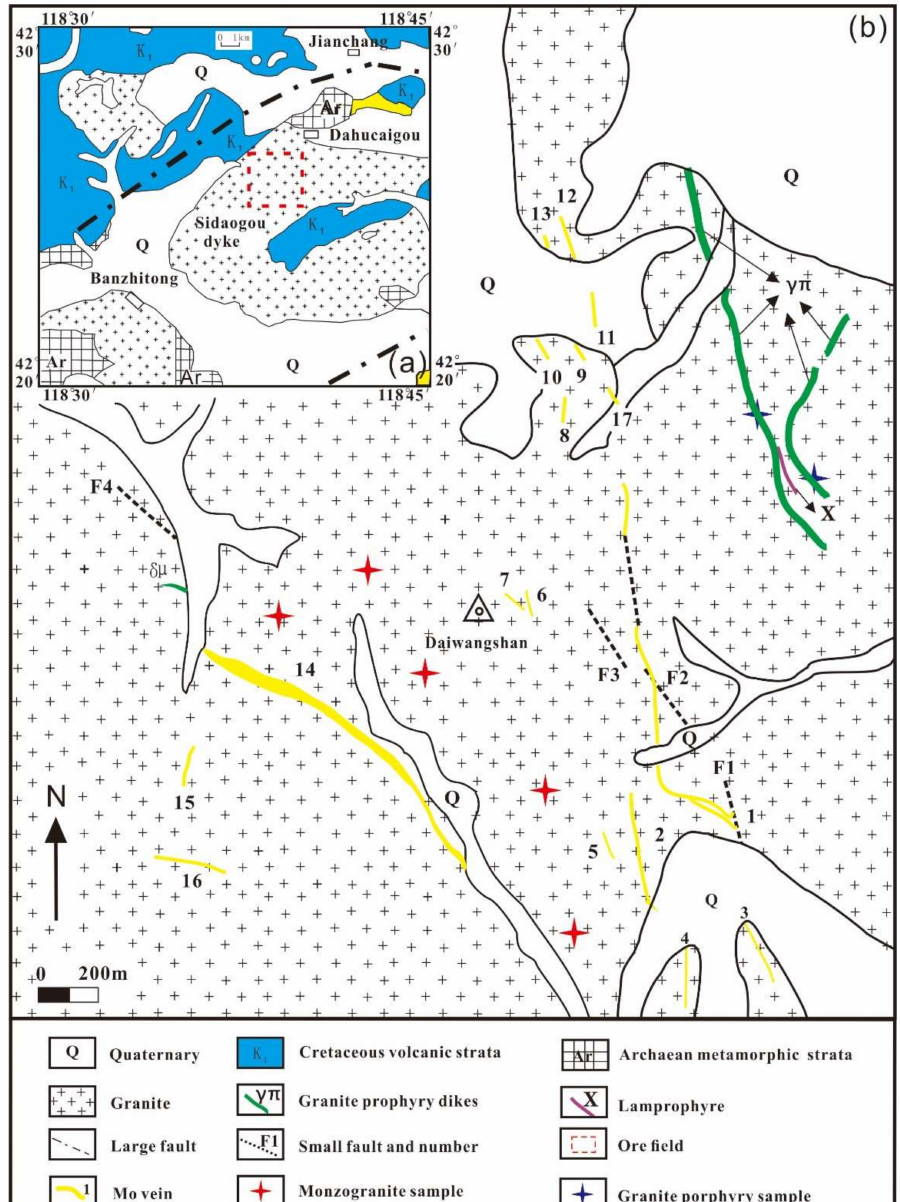
Figure 2. Geological sketch map of the host granite and the Nianzigou Mo deposit. ( a ) Deposit location, ( b ) ore vein distribution (modified after Chen et al., 2008)